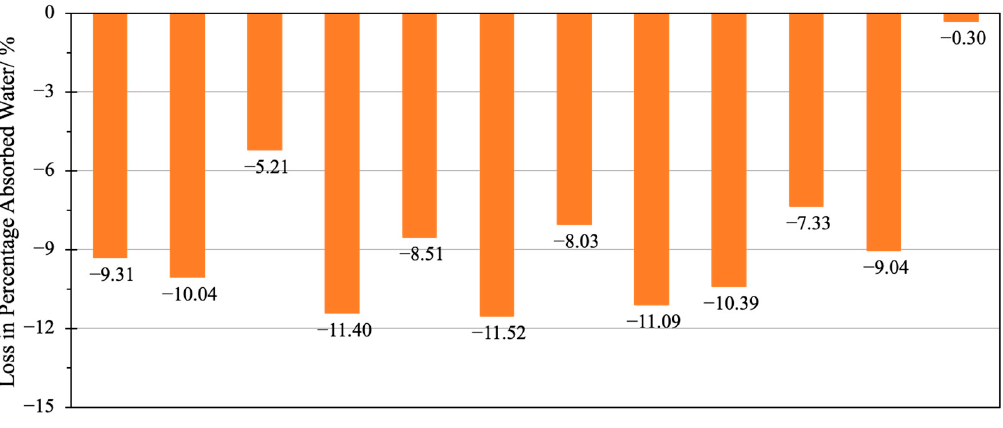
Figure 10. Change in percentage of absorbed water.